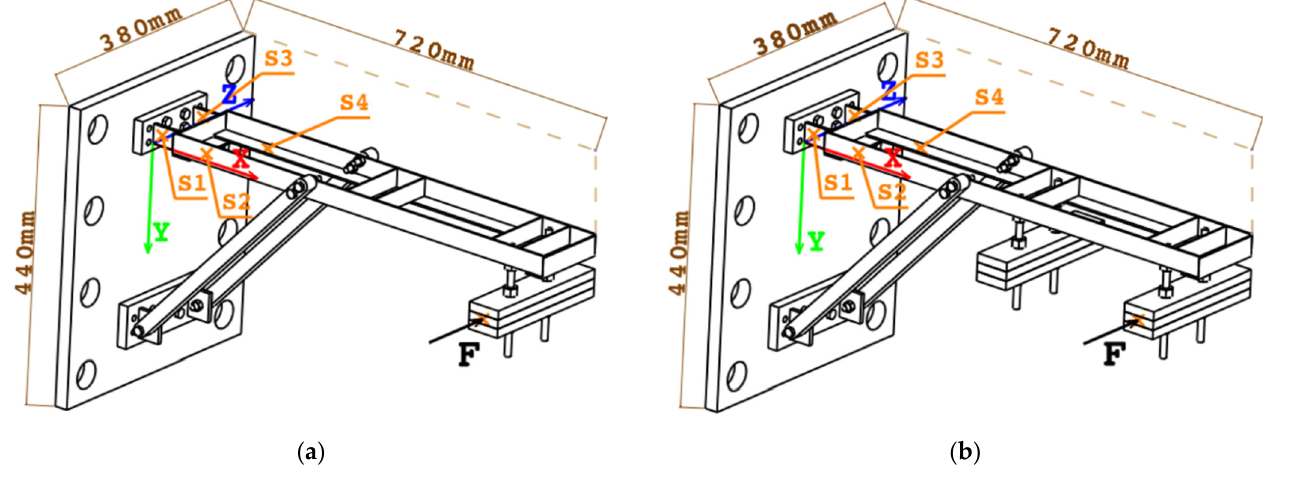
Figure 2. Coordinate system and strain gauge layout . ( a ) Single pylon test model ( b ) double pylon test model.